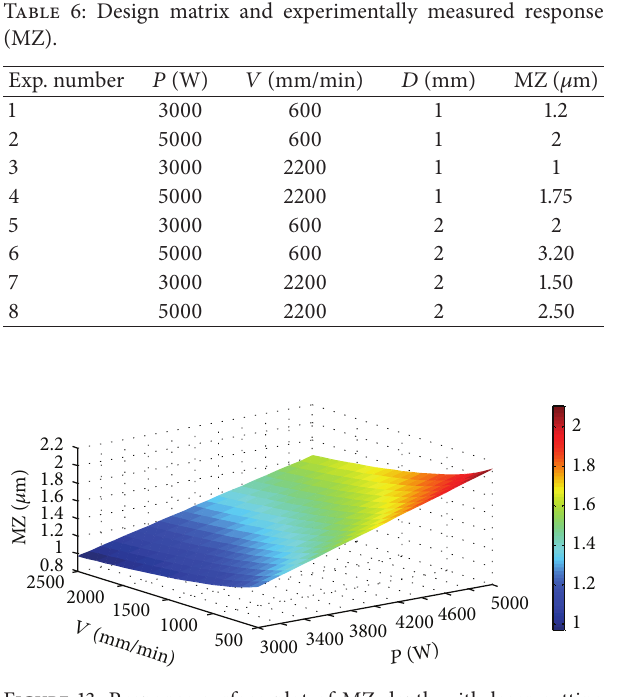
Figure 13: Response surface plot of MZ depth with laser cutting speed and laser power ( 𝐷 = 1 mm).